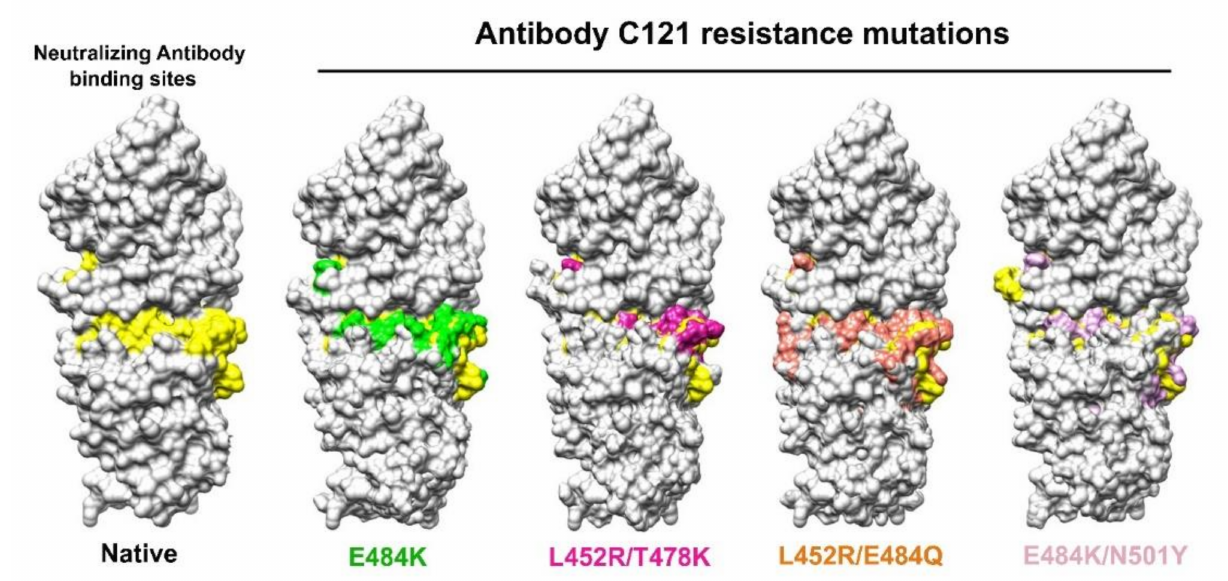
Figure 5. Changes of antibody binding sites in the double-mutated RBD. The binding sites (N439, N440, L455, G446, E484, and Q493) of neutralizing antibody C121 (PDB ID: 7K8X) were compared between the Native, E484K, known for escaping C121 binding, and double mutants L452R/T478K, L452R/E484Q, and E484K/N501Y. Yellow: C121 binding sites on Native RBD; Green: C121 binding sites on E484K RBD; Magenta: C121 binding sites on L452R/T478K RBD; Orange: C121 binding sites on L452R/E484Q RBD; Pink: C121 binding sites on E484K/N501Y RBD. It shows that all three double-mutated RBDs altered C121 binding sites at different degrees, as reflected by the changed yellow color in each case. L452R/E484Q showed greater overlap with yellow color than other double mutants, confirming the resistance of E484K to